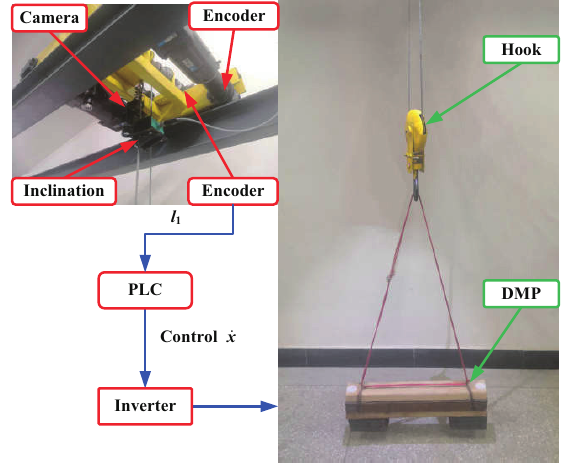
Figure 5. A double pendulum bridge crane with the